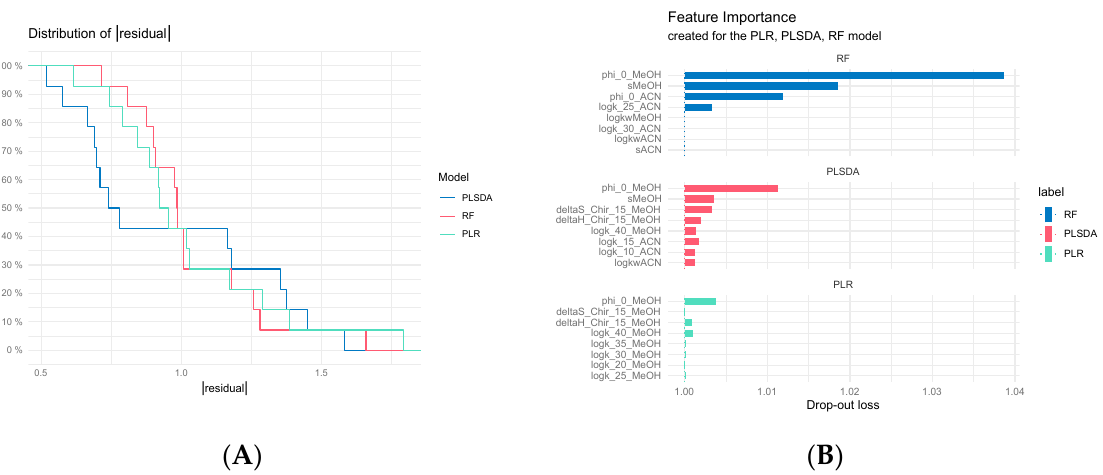
Figure 11. Distribution of residuals ( A ) and variable importance for the set of optimal RFE (Recursive Feature Elimination) predictors ( B ) of three estimated models.